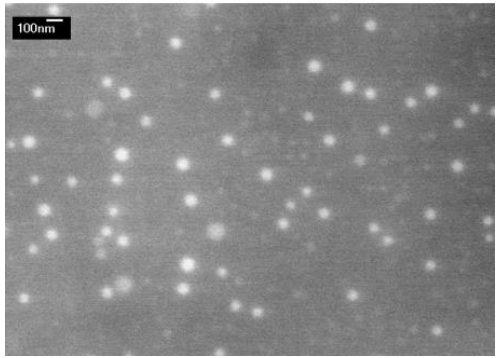
Figure 1. SEM images of particle-containing silica core. Particles were obtained by adding MgCl 2 in the core (figure courtesy of Dr. Wilfried Blanc, University of Nice Sophia Antipolis, France).